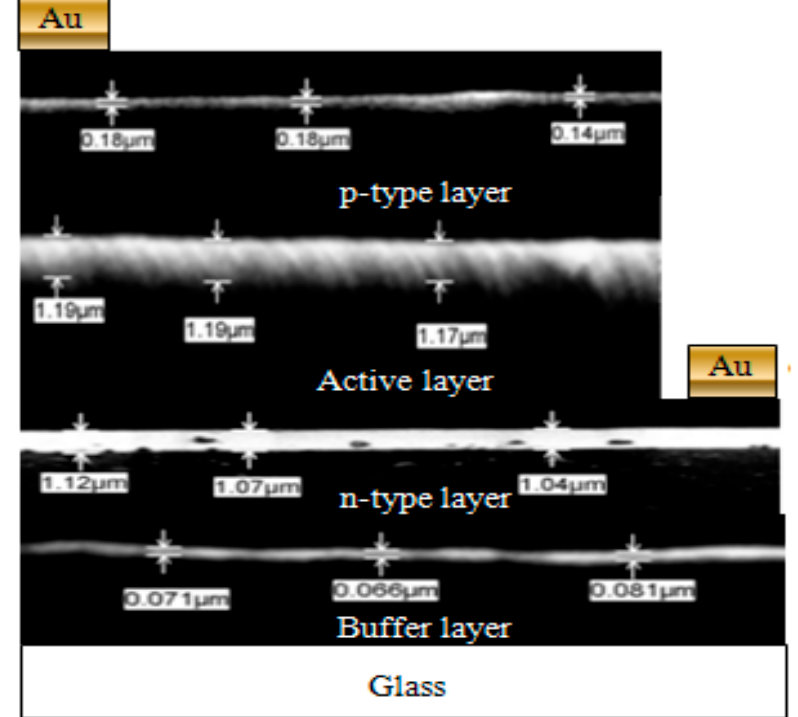
Figure 9. Cross-section of the In 0.1 Ga 0.9 N LED.